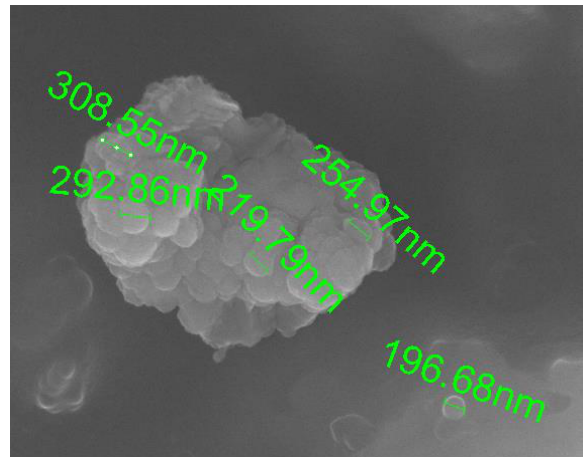
Figure 16. Smaller grain agglomerates and individual nanoparticles in a moist environment (humidity 70%). Samples were collected from the bottom of the test chamber.